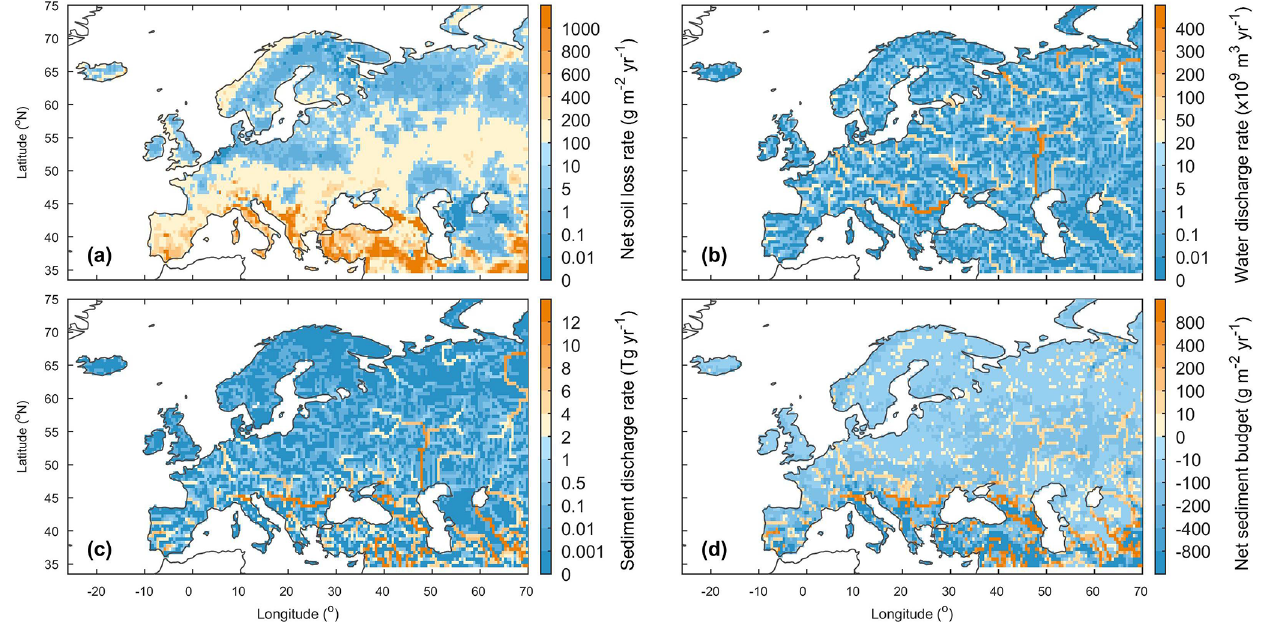
Figure 9. Averaged annual lateral redistribution rate of water and sediment in Europe during 1901–2014. (a) Annual sediment delivery rate from upland to the river network; (b) annual water discharge rate; (c) annual sediment discharge rate; (d) annual net sediment budget in each